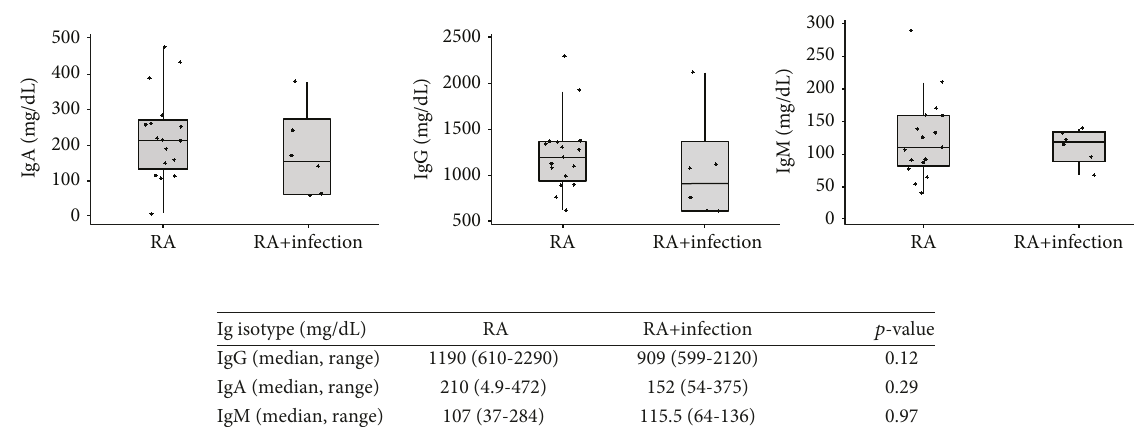
Figure 5: Box plots and analyses comparing serum immunoglobulins (IgG, IgA, or IgM) in RA patients with infections and without infections. The median value is indicated with a horizontal line, with the box comprising the IQR and whiskers representing the maximum and minimum values within the fences ( ± 1.5 IQR). Comparisons between groups were performed using Wilcoxon rank-sum tests. No statistically signi fi cant di ff erences were found in serum IgG, IgA, or IgM between the two patient